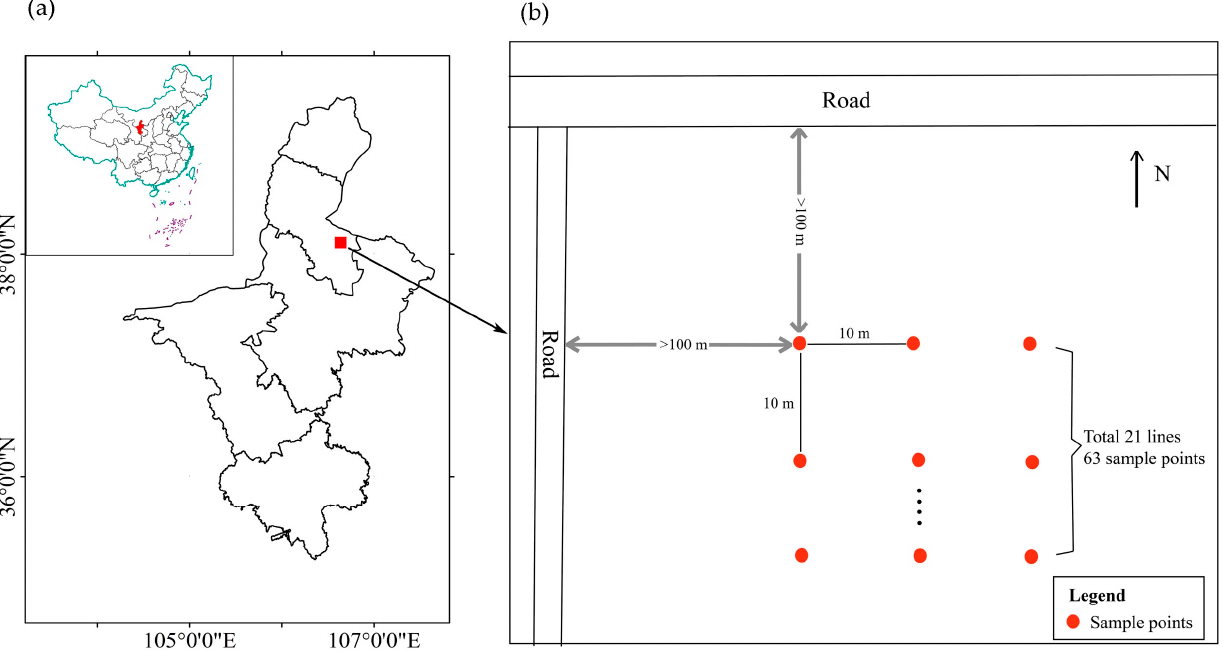
Figure 1. Schematic diagram of the plot. ( a ) Location map of the study area, ( b ) sampling design.